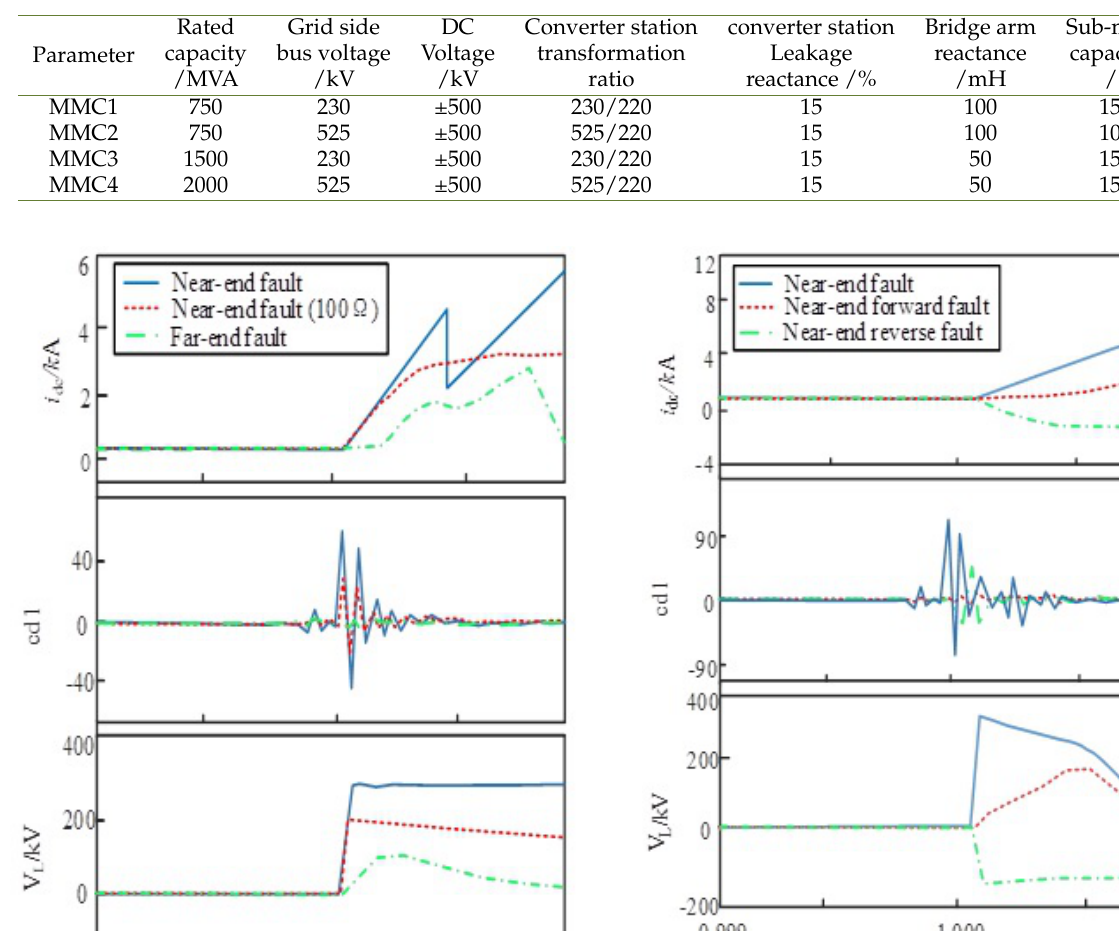
Table 2. Basic parameters of the VSC-HVDC grids simulation system.